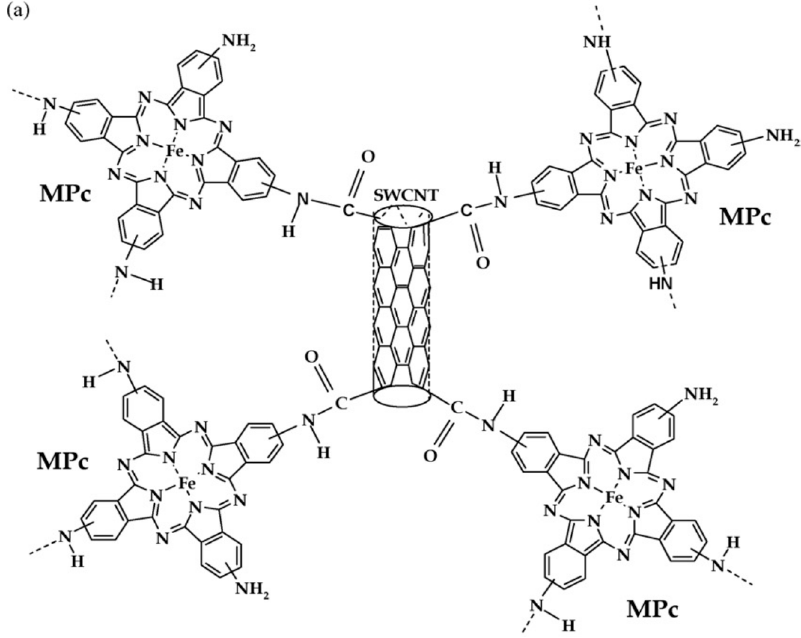
Figure 2. Representation of dendrimers formed between a SWCNT and FeTAPc. (Reproduced with permission of Elsevier from [78]).